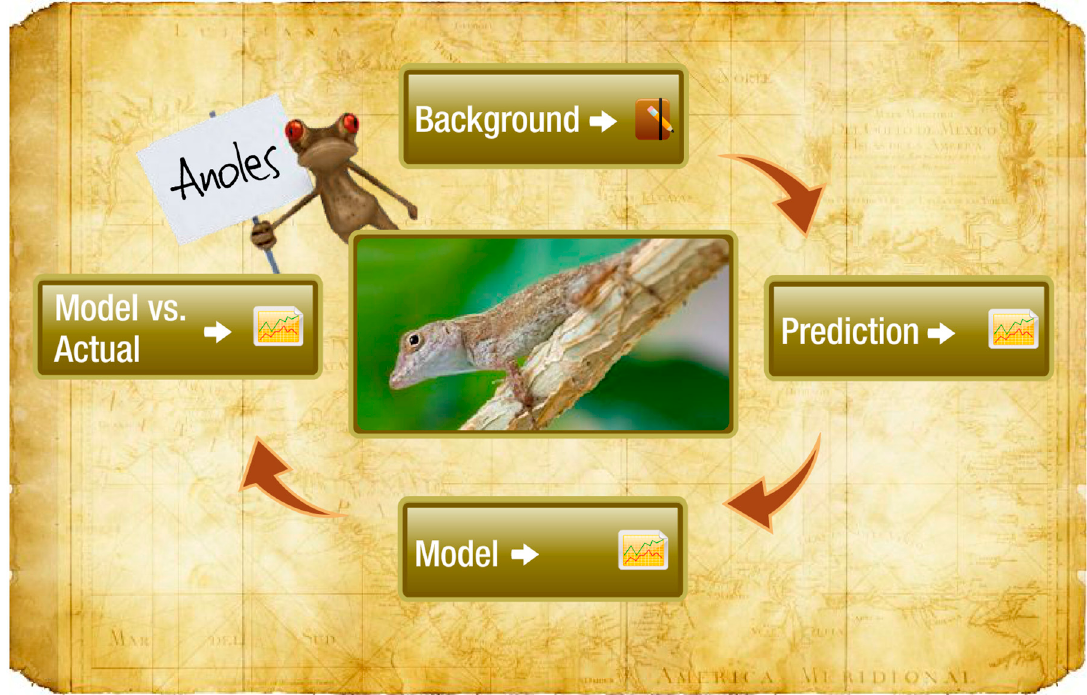
Figure 2. Screenshot of the investigation cycle for the anole in Journey to El Yunque . All of the consumer species in Journey to El Yunque have the same set of steps.